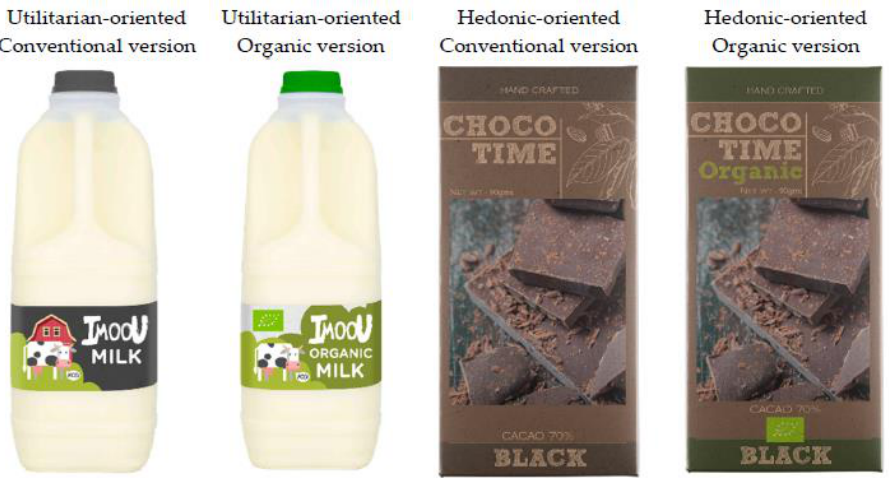
Figure 2. Examples of products designed for the Implicit Association Test.